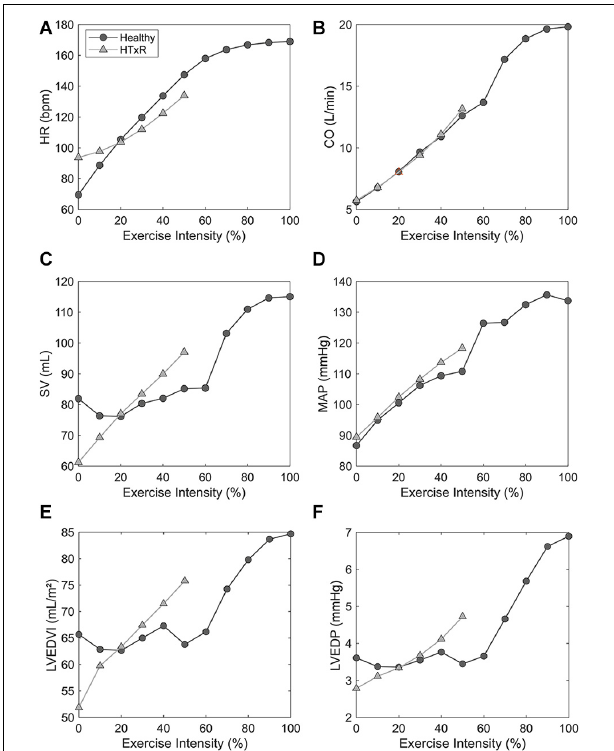
FIGURE 4 | Comparison of exercise response between HTxRs and healthy controls, characterized by selected hemodynamic variables. The horizontal axis shows the relative exercise intensity with respect to the peak exercise intensity of the healthy control group (1,032 kpm/min). Note the substantial reduction of exercise capacity in HTxRs, reaching only about 50% (522 kpm/min) of the healthy control’s peak exercise intensity. We can see a marked impairment of chronotropic response and reduced peak HR in HTxRs (A) . Furthermore, the simulation results show no significant differences in augmentation in CO but substantially decreased peak CO in HTxRs (B) . Resting SV is notably reduced in HTxRs and undergoes a rapid increase in response to exercise (C) . MAP response is similar in both groups; however, healthy controls reach higher peak values due to greater exercise intensity (D) . Despite the reduced absolute values, HTxRs show a markedly stronger augmentation of LVEDVI in response to exercise (E) . Simulations predict a similar resting LVEDP for both the HTxRs, however, the augmentation of LVEDP is markedly stronger than in age- and gender-matched healthy individuals (F) . HR, heart rate; CO, cardiac output; SV, stroke volume; MAP, mean arterial pressure; LVEDVI, left ventricular end-diastolic volume index; LVEDP, left ventricular end-diastolic